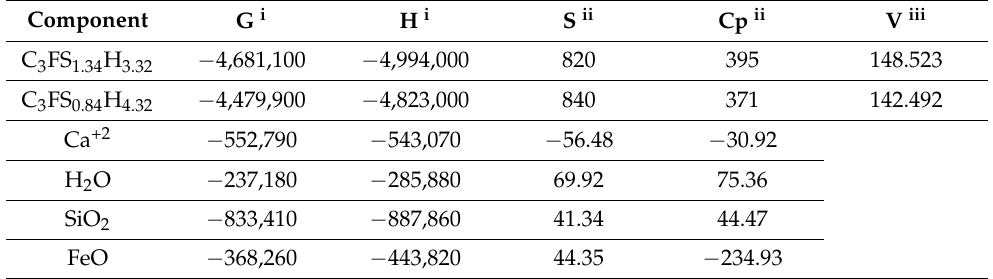
Table 6. Thermodynamic properties of Si-hydrogarnet as taken from the cemdata18 database [25]. Letters assigned to each end-member are shown in parentheses.